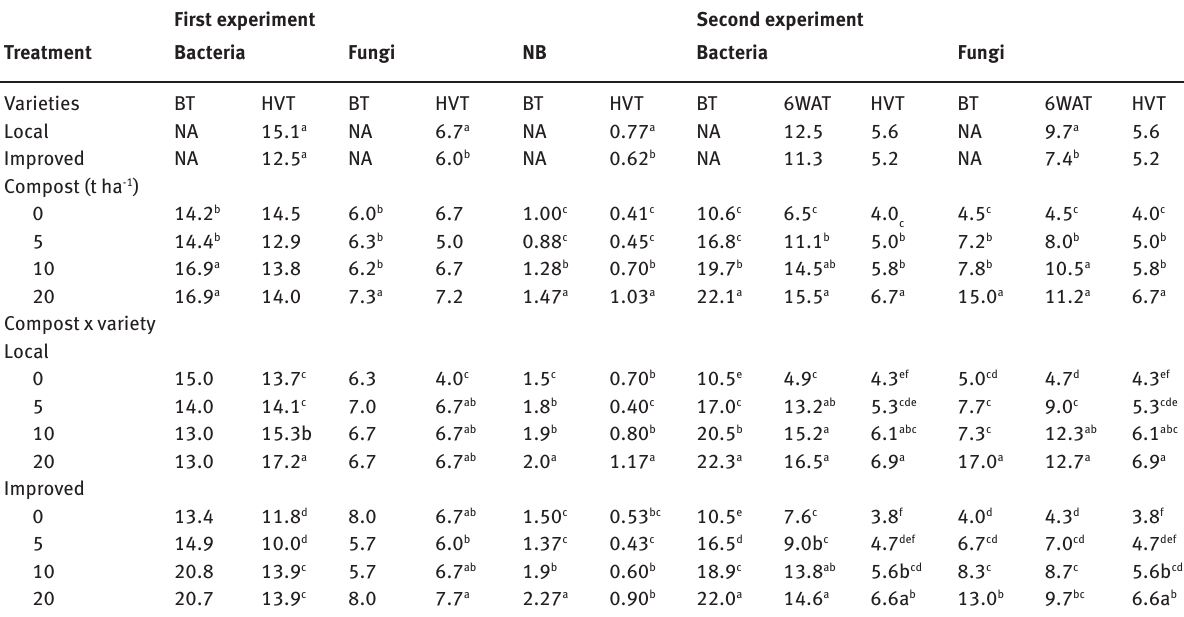
Table 1: Soil bacterial (10 5 cfu g -1 soil) and fungal (10 4 cfu g -1 soil) populations in two pot experiments with 4 rates of compost and to 2